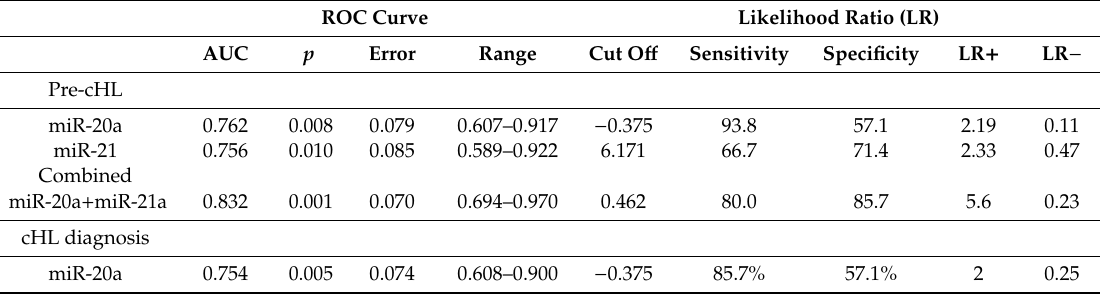
Table 5. ROC curve and likelihood ratio analysis at pre-cHL and cHL